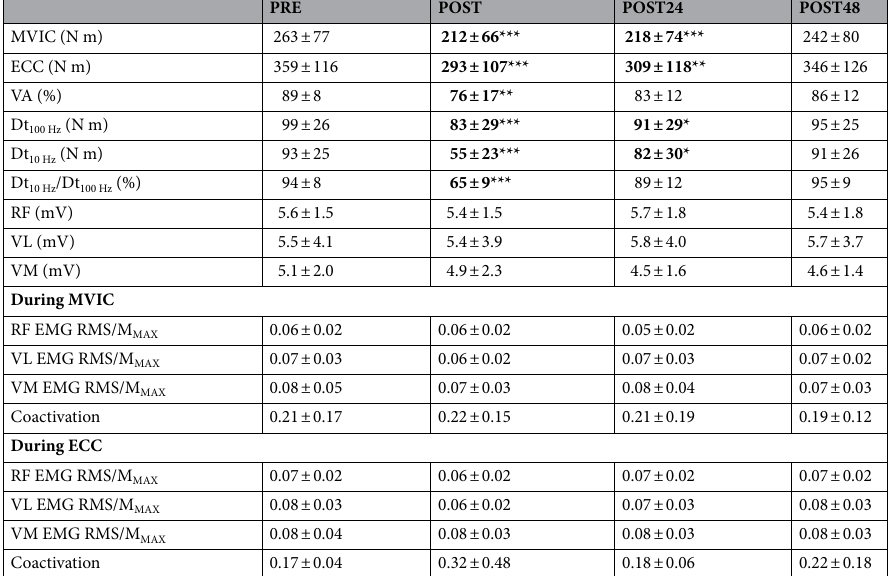
Table 1. Mean values ± SD of neuromuscular function parameters at each time point. Bold values are significant. *, ** and ***Significantly different from PRE values at p < 0.05, at p < 0.01 and at p < 0.001, respectively. MVIC Maximal Voluntary Isometric Contraction, ECC maximal voluntary eccentric contraction, VA Voluntary Activation level, Dt 100 Hz potentiated doublet amplitude at 100 Hz, Dt 10 Hz potentiated